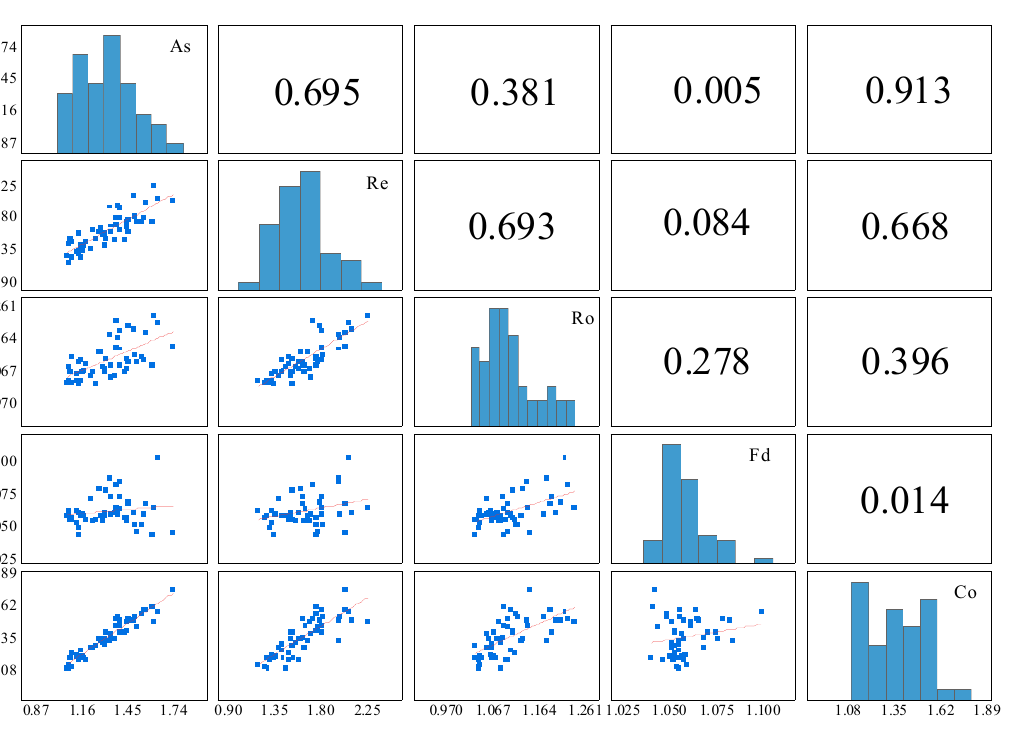
Figure 14. Scatterplots and Pearson correlation coefficients of the particle shape parameters.